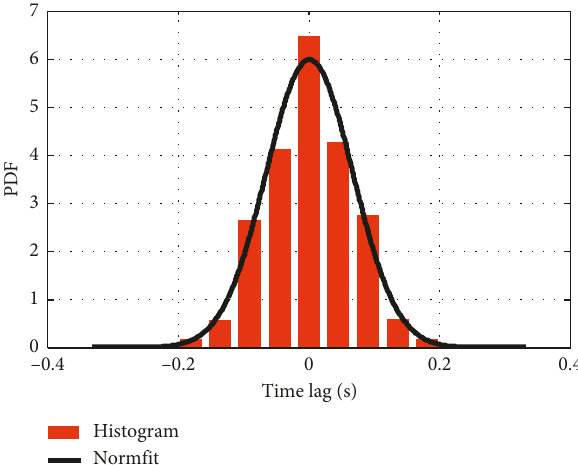
Figure 17: PDF of the time lags between each two participants at 1.8 Hz for the reference